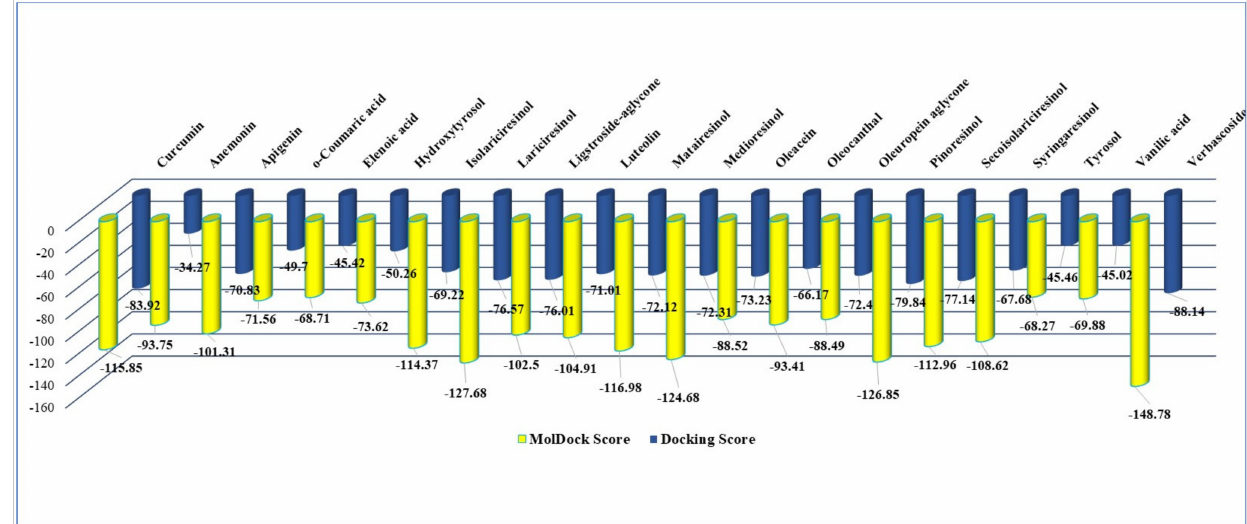
Figure 11. The docking score and MolDock score of the 20 test vegetal compounds in the study in comparison with